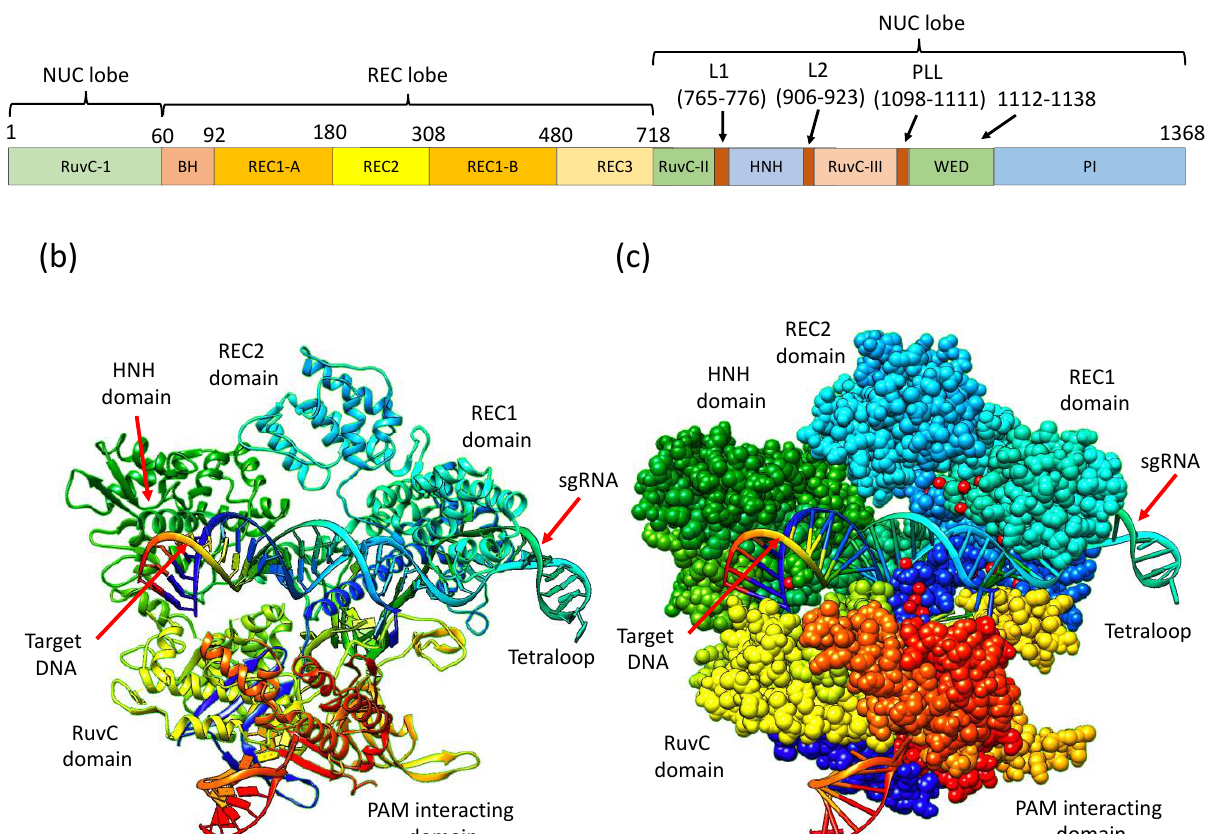
Figure 1. Domain organization of SpCas9 and three-dimensional structure of SpCas9-sgRNA-DNA ternary complex shown by ( a ) domain organization of Cas9, ( b ) ribbon representation, and ( c ) space- filling model, obtained from protein data bank (PDB) at https://www.rcsb.org (accessed on 12 January 2023), PDB ID: 4OO8 and edited by UCSF